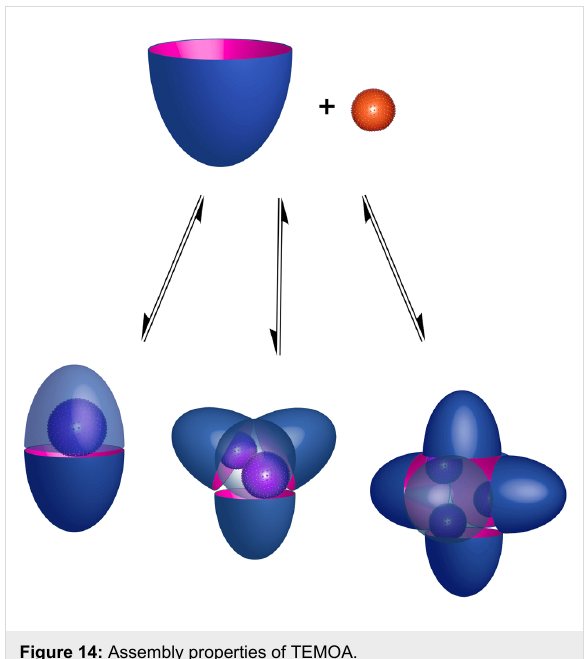
Figure 14: Assembly properties of TEMOA.